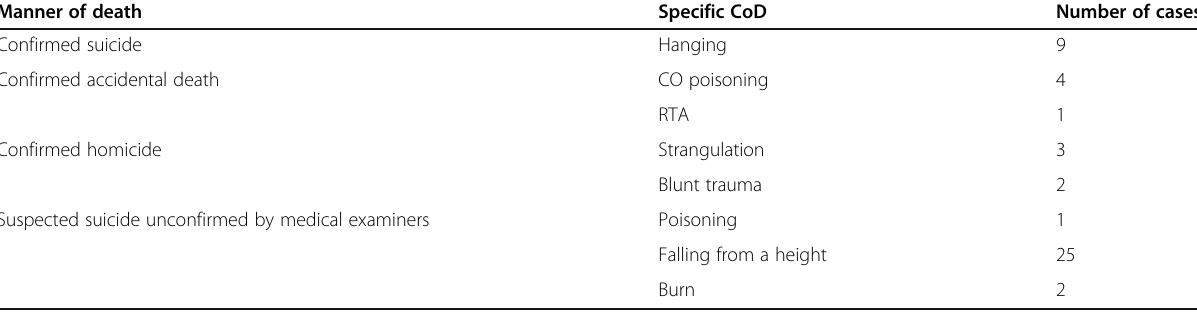
Table 2 Profile of unnatural deaths and their circumstances among the domestic workers Manner of